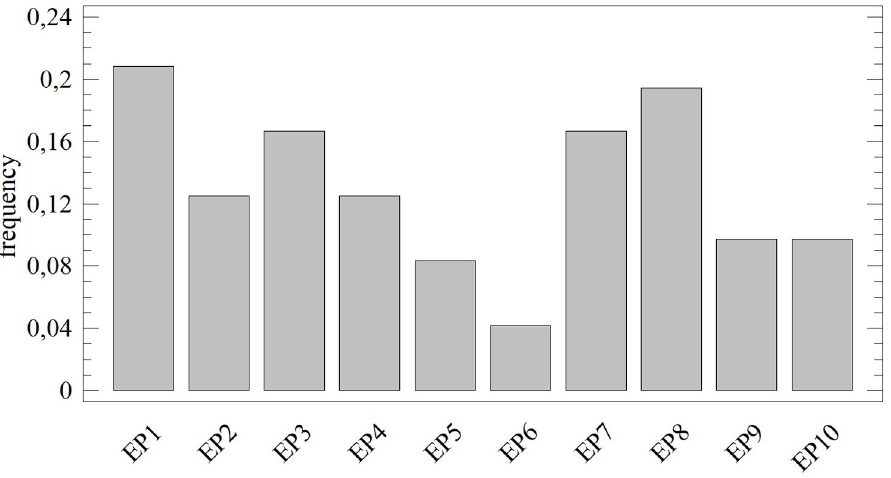
Fig 9. Comparison of the agreement of the results of the TOPSIS method using the Jaccard index (CV vs. SD).